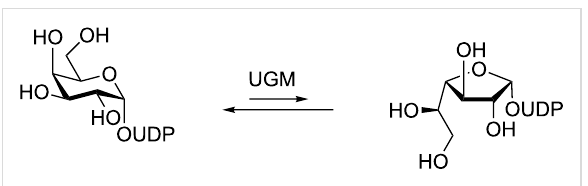
Scheme 11: UDP-galactopyranose mutase-catalyzed isomerization of UDP-Gal p to UDP-Gal